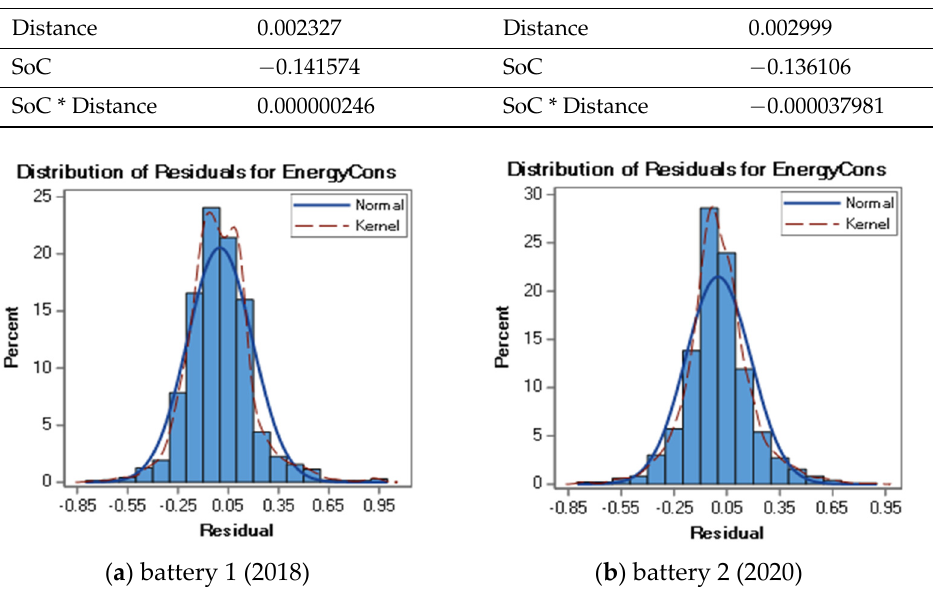
Figure 4. Distribution of residuals for the optimal models of the tested batteries: ( a ) battery